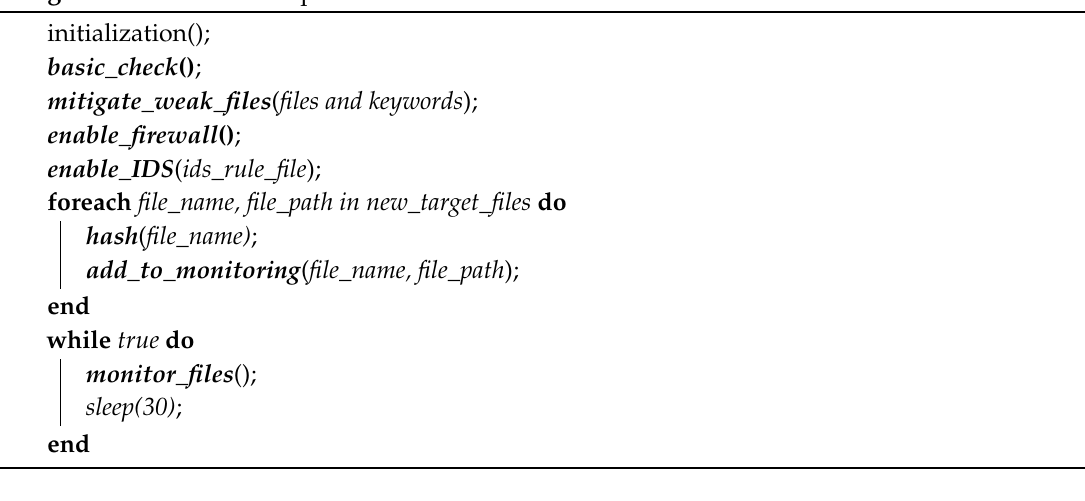
Algorithm 4: The overall